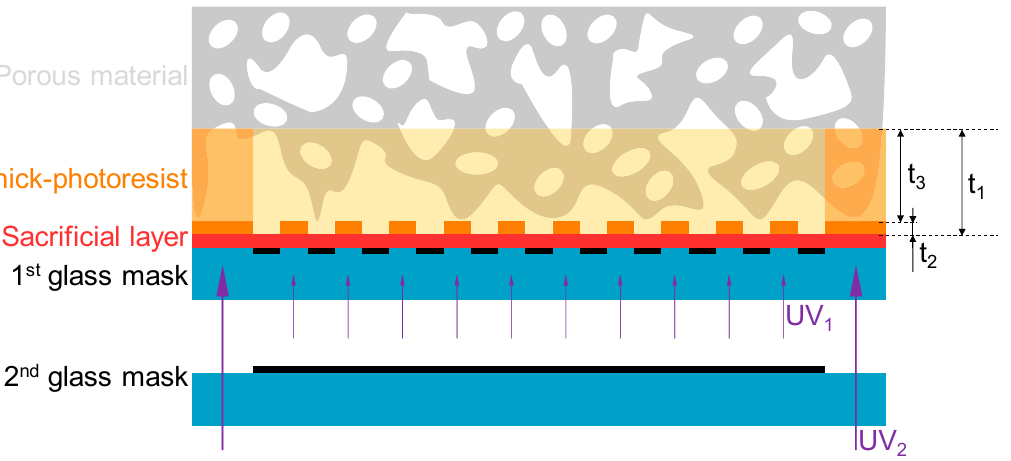
Figure 2. Principle of the proposed method. For micropatterning on a porous material, the method uses SU-8, which is a negative type thick photoresist, a sacrificial layer for releasing, and two glass masks.